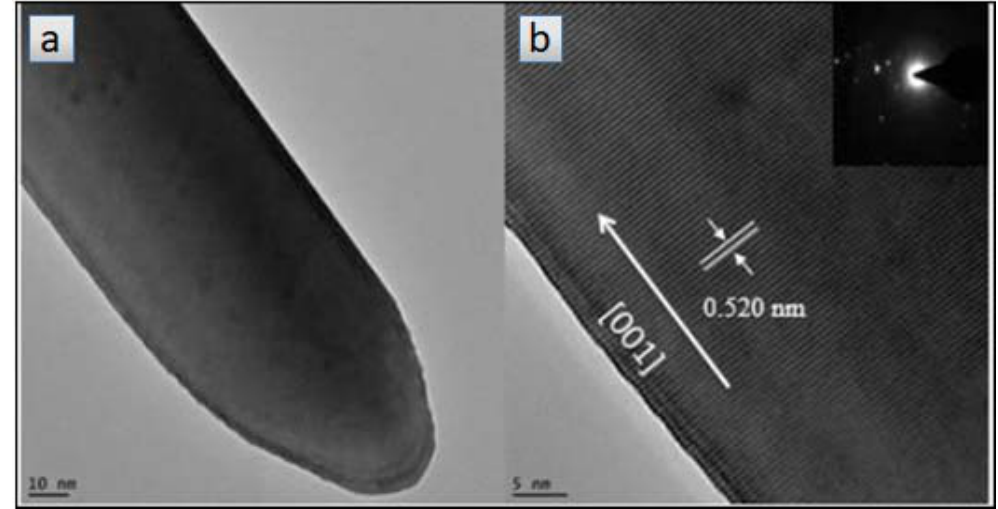
Figure 16. HRTEM images of the ZnO NWs at different magnifications. The inset corresponds to the SAED pattern of the ZnO NWs (D). Reproduced with permission from reference [132].